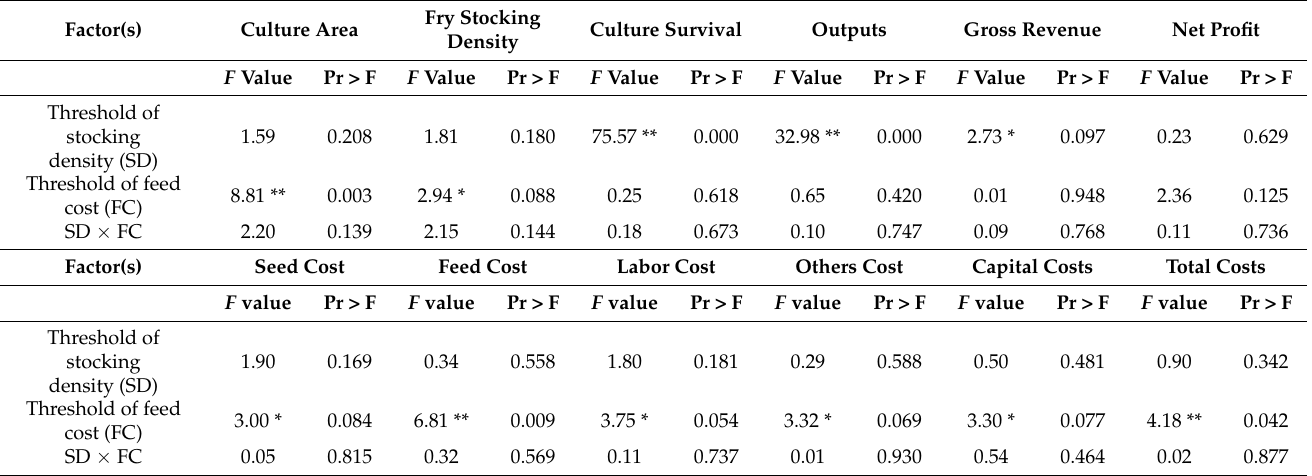
Table 3. Two-way ANOVA analysis of stocking density and feed cost for hard clam aquafarms in Taiwan (output, profitability, and input intensities).